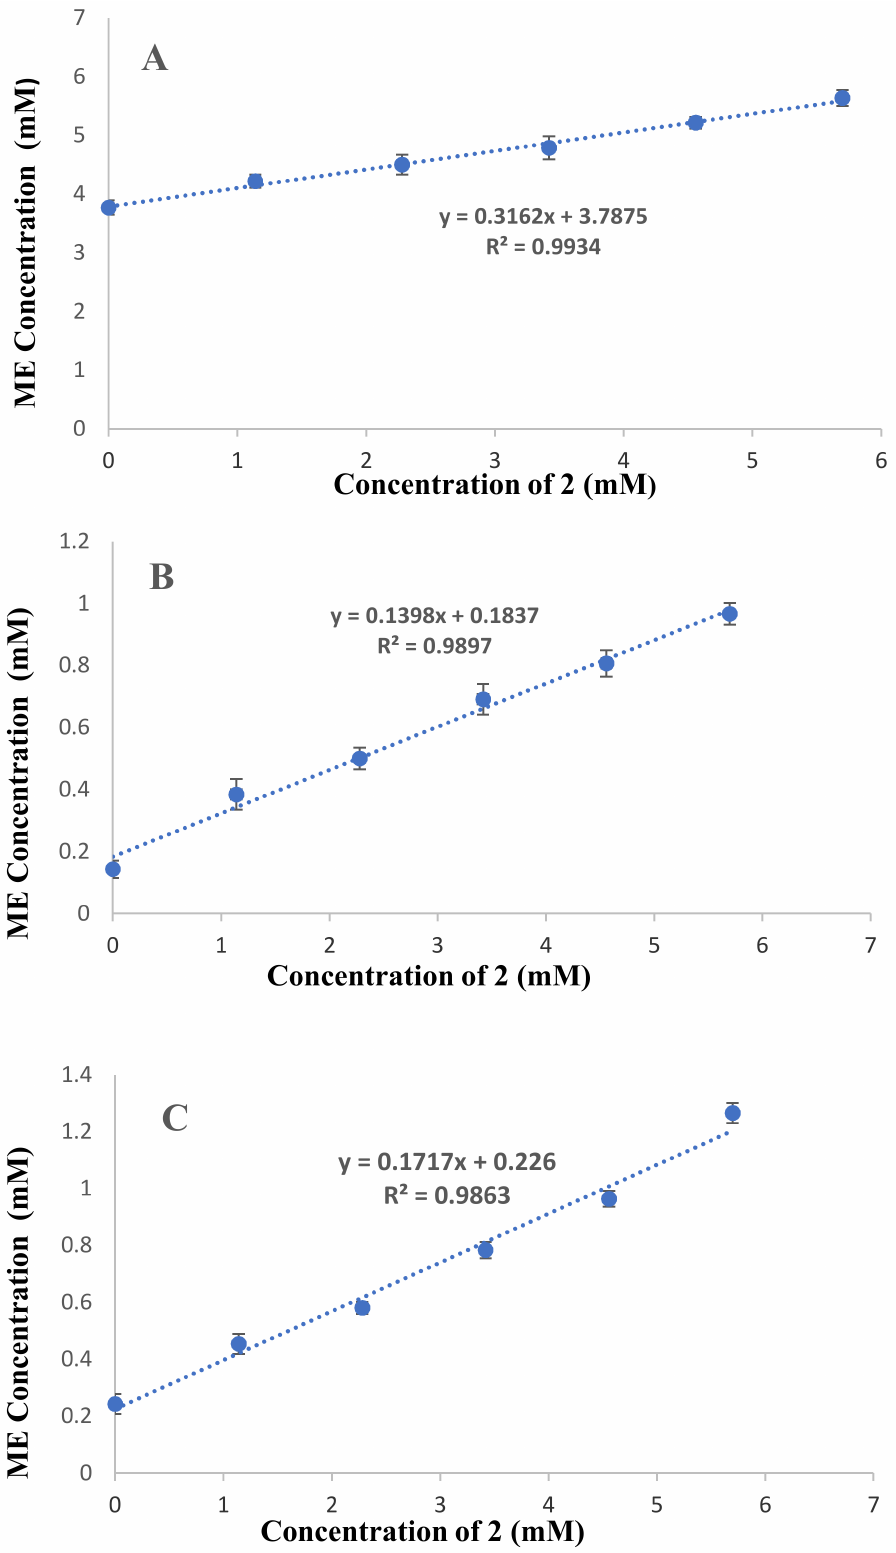
Figure 1. Phase solubility diagram of ME in presence of different concentrations of sulfona- tocalix[4]naphthalene at temp. 25.5 ± 0.5 ◦ C. ( A ) Phosphate buffer of pH 7.4, ( B ) pH 1.2, and ( C ) distilled